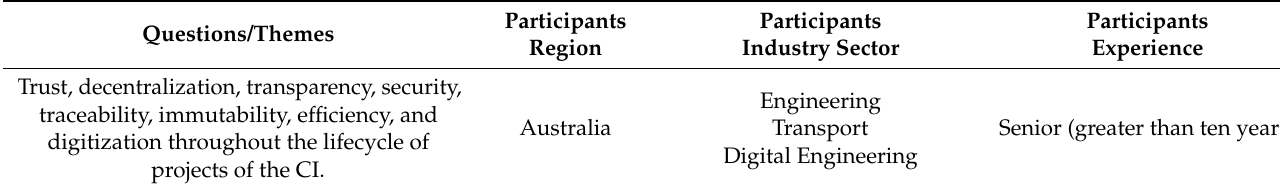
Figure 1. Flowchart of the research method, including six key steps. Table 4. Interviews’ summary